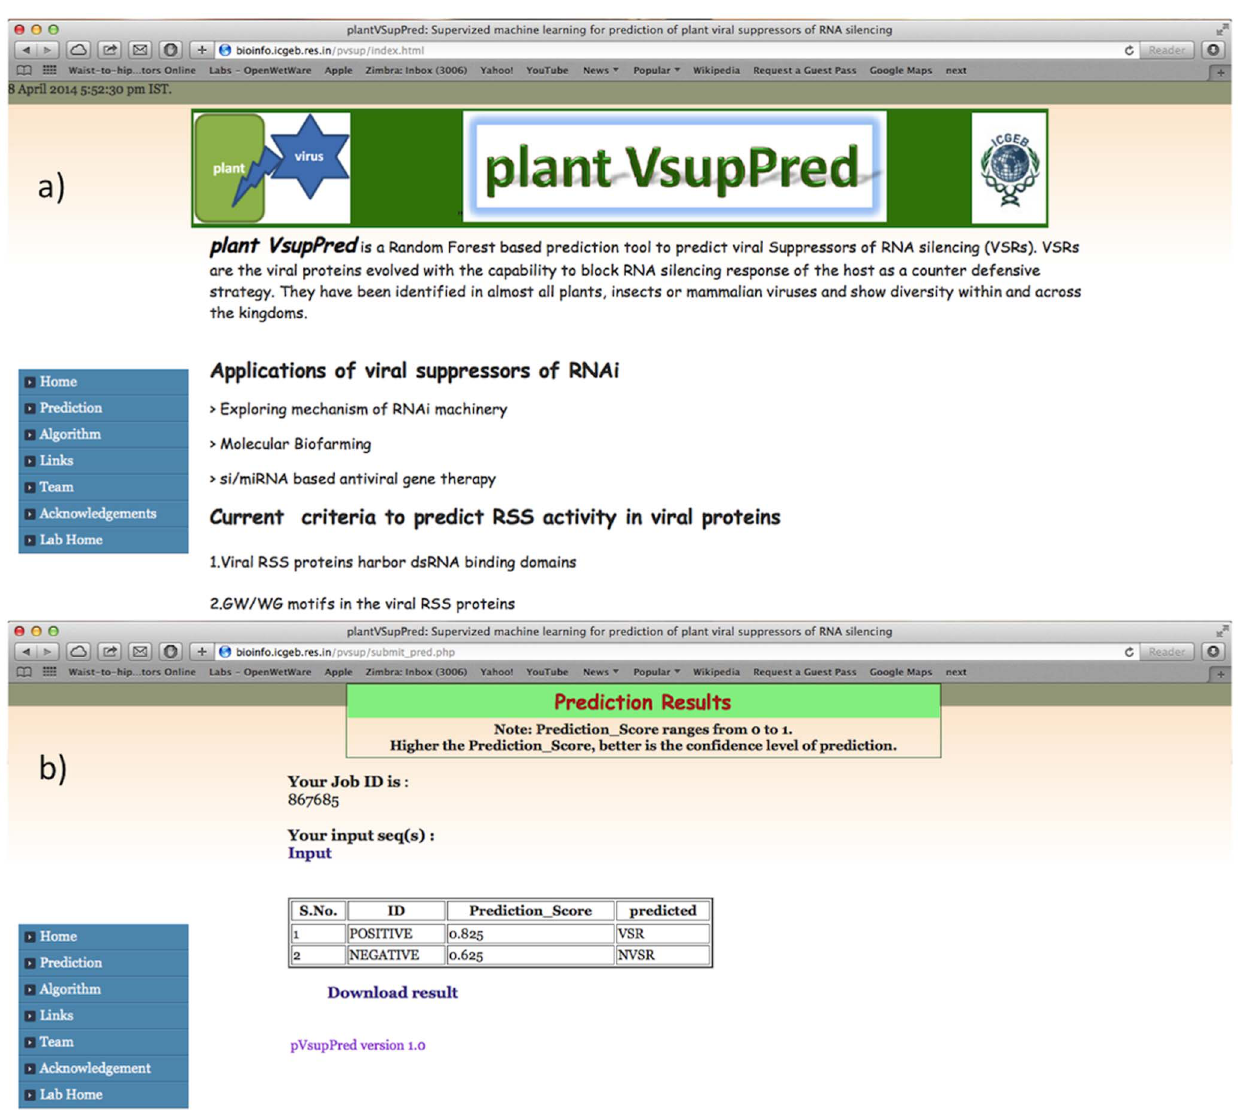
Figure 5. Snapshot of pVsupPred web server. The web server predicts viral suppressor of RNA silencing based on Random Forest classifier generated in this study. Figure 5a is snapshot of prediction page of pVsupPred webserver. The webserver accepts FASTA formatted